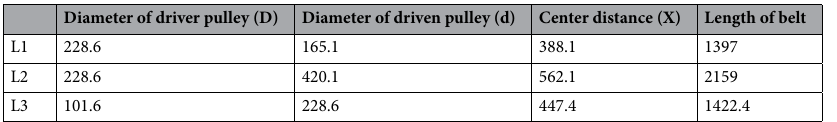
Table 2. Length of belt calculation table (all units are in